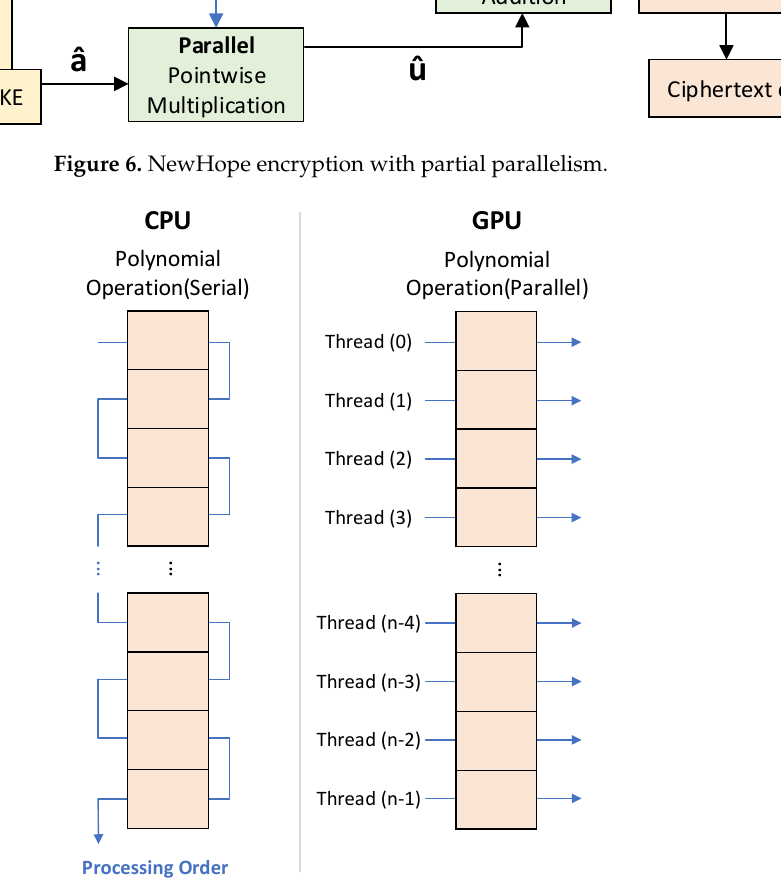
Figure 7. Parallel polynomial operation